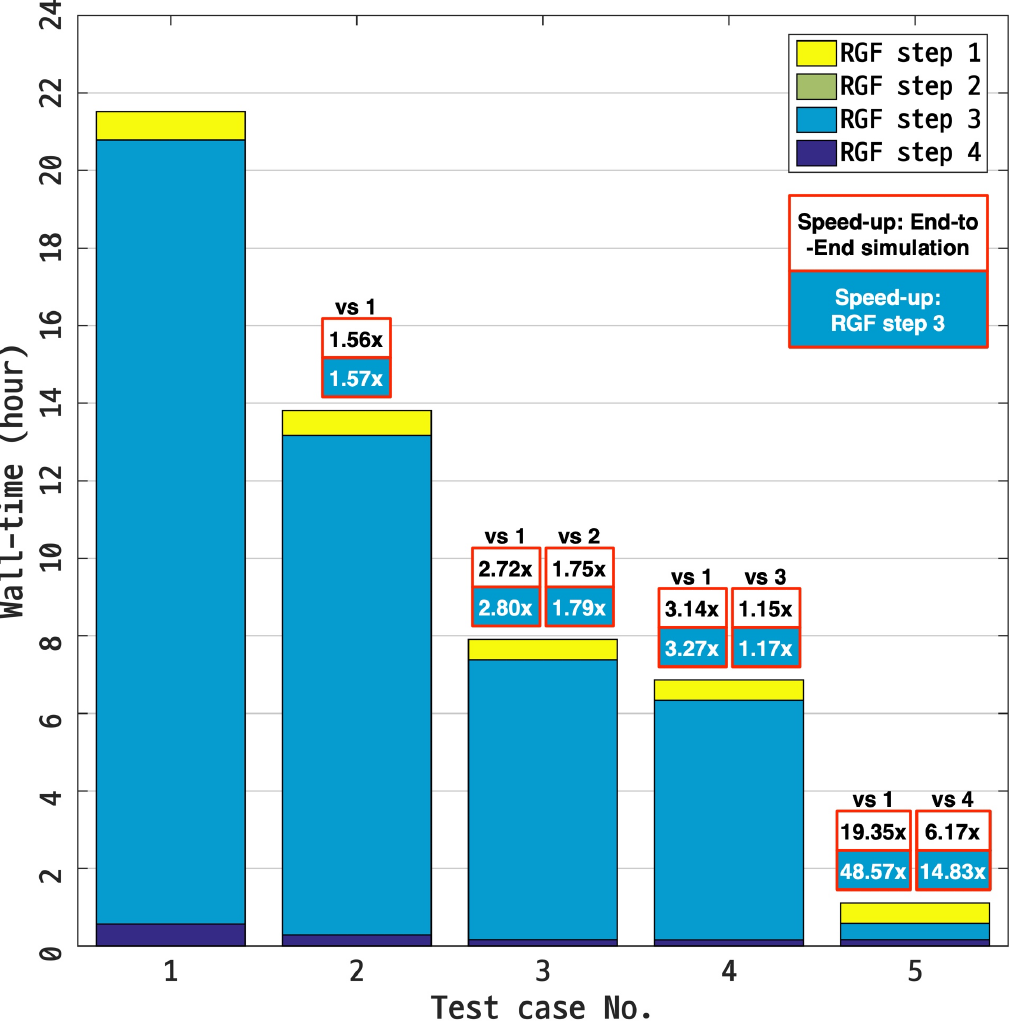
Figure 7. Results of single-node performance tests. The wall-time of the entire RGF process is split into the 4 components that indicate the time taken to complete the 4 steps described in Figure 1. In the five test cases, the computation was conducted with one or more performance optimization enhancement techniques, according to the plan summarized in Table 3. Compared to the unoptimized case (Case 1 in Table 3), the performance of the entire computation and step 3 were improved by factors of 19.35 and 48.57, respectively, when all four optimization techniques were